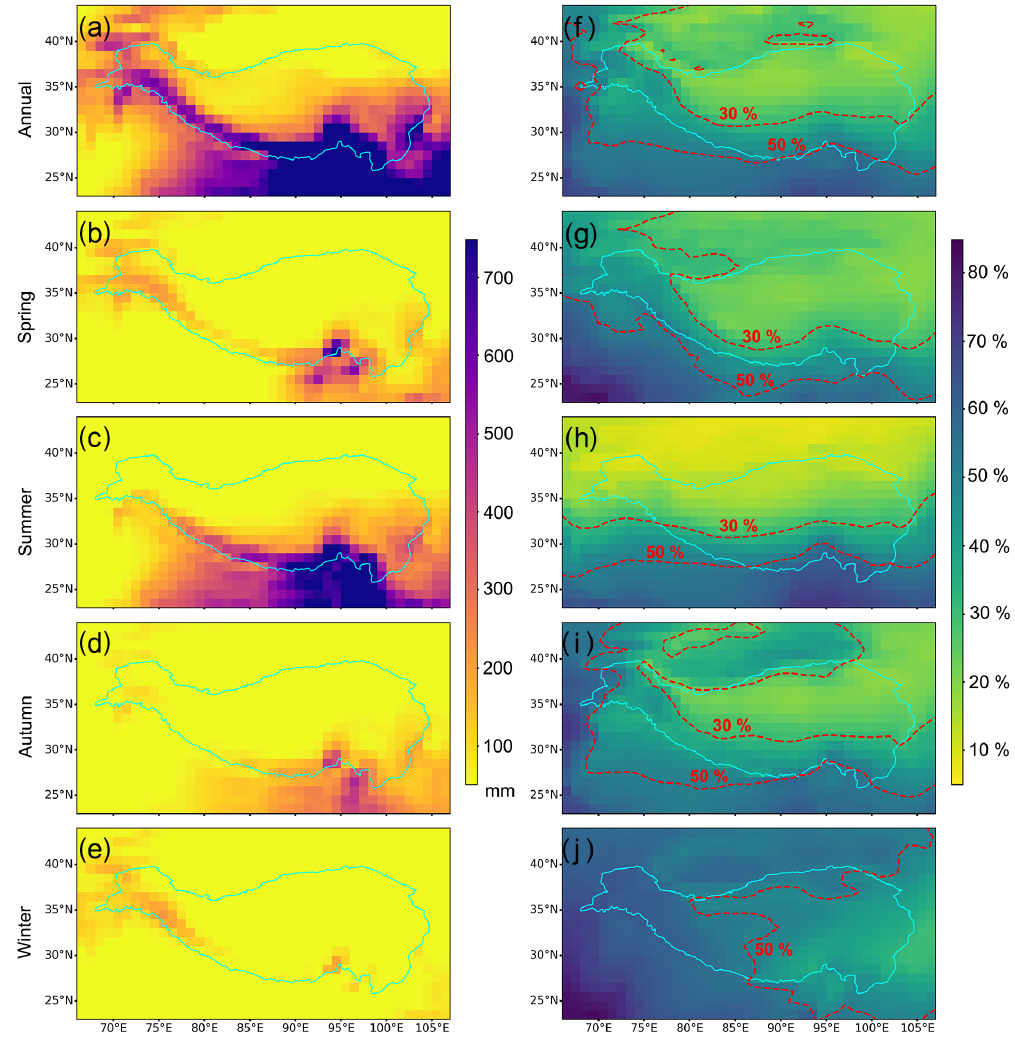
Figure 1. Spatial distributions of long-term mean absolute and relative oceanic moisture contributions to the TP precipitation. ( a – e ) The absolute contribution from global oceans (mm, equivalent water height) on annual (mmyr − 1 ) and seasonal (mm season − 1 ) scales. ( f – j ) The relative contribution of oceanic moisture (%, the percentage of oceanic contribution relative to total moisture convergence) on annual and seasonal scales. Cyan lines represent the TP boundary and dashed red lines in ( f – j ) are 30% and 50% isolines of the relative contribution. The forward moisture tracking results are modeled using WAM-2layers driven by ERA-Interim during 1979–2015. Moisture-tracking results driven by MERRA-2 (1980–2015) and JRA-55 (1979–2015) are shown in Figs. S3 and S4,